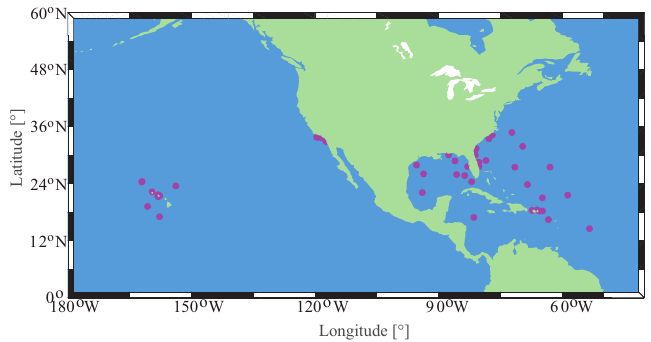
Figure 2. Locations of the NDBC buoys used in this